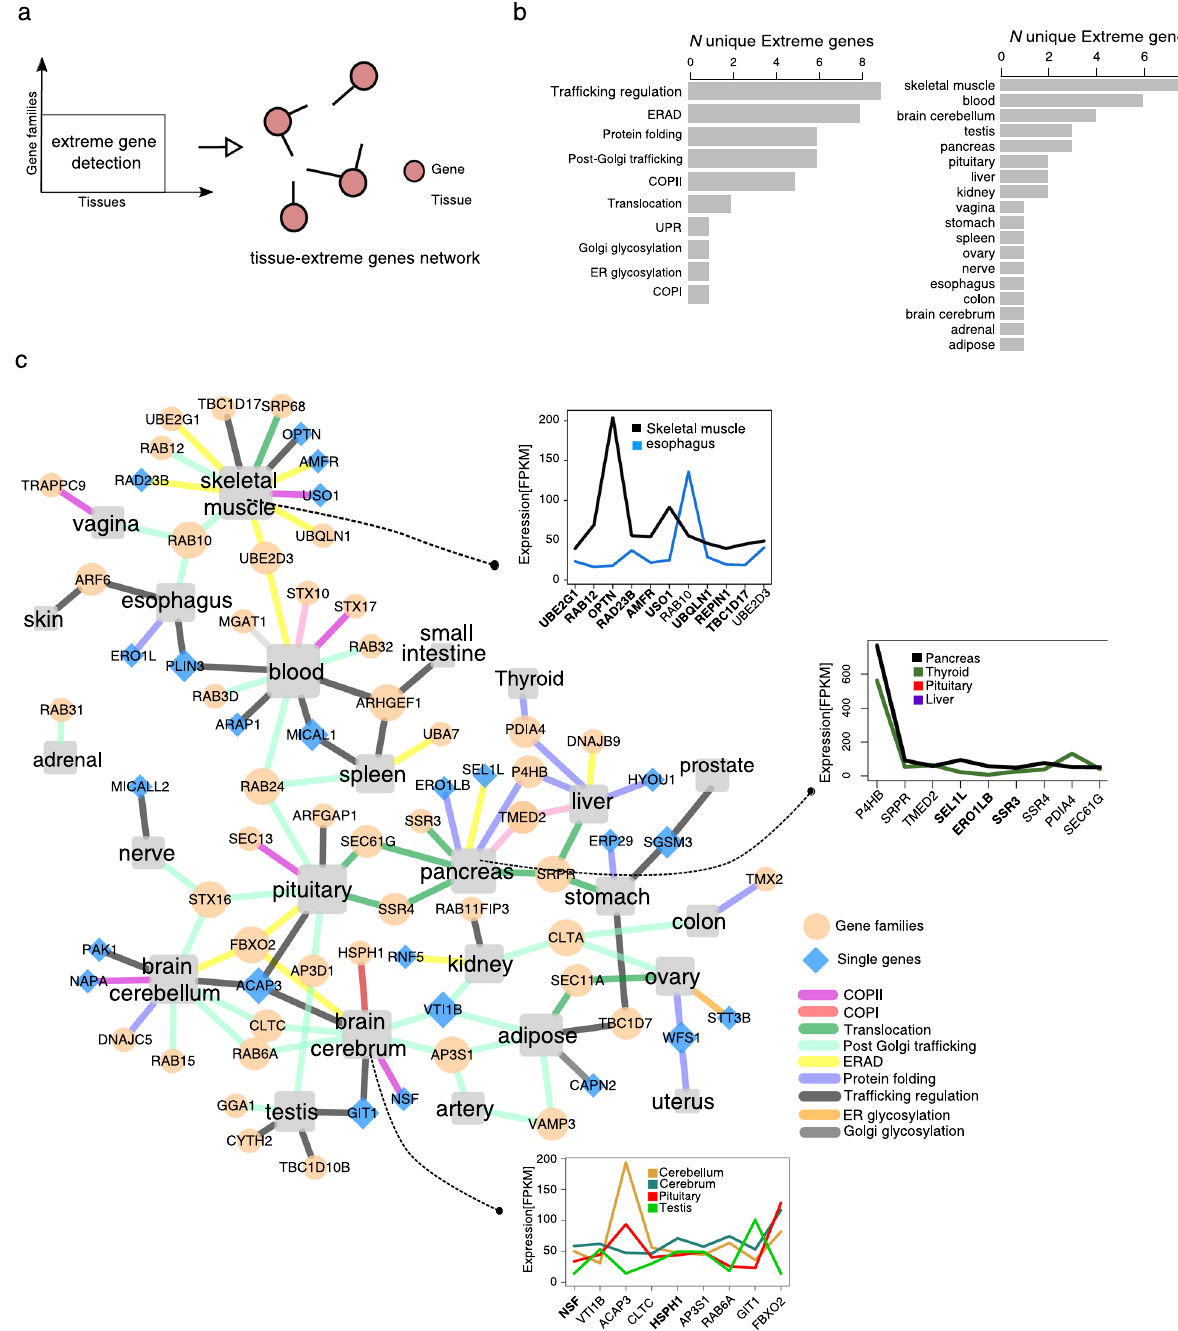
Fig. 4 Detecting the tissue-speci fi c extreme genes of secretory pathway genes families. a A simple work fl ow of the detection strategy of the extreme genes is shown. b shows the frequency of the extreme genes per subsystem and per tissue. c The represented network is the reconstructed tissue-extreme gene network. Extreme genes, whether as individual genes ( blue diamonds ) or as part of a gene family ( pale orange circles ), were grouped in the associated subsystem, and linked to each tissue ( gray box ) were they were detected as extreme. The detail expression level for three tissue (skeletal muscle, pancreas, and brain cerebrum) are plotted in the inboxes for their fi rst neighbored detected extreme genes. All other colors not de fi ned in the box refer to other tissue